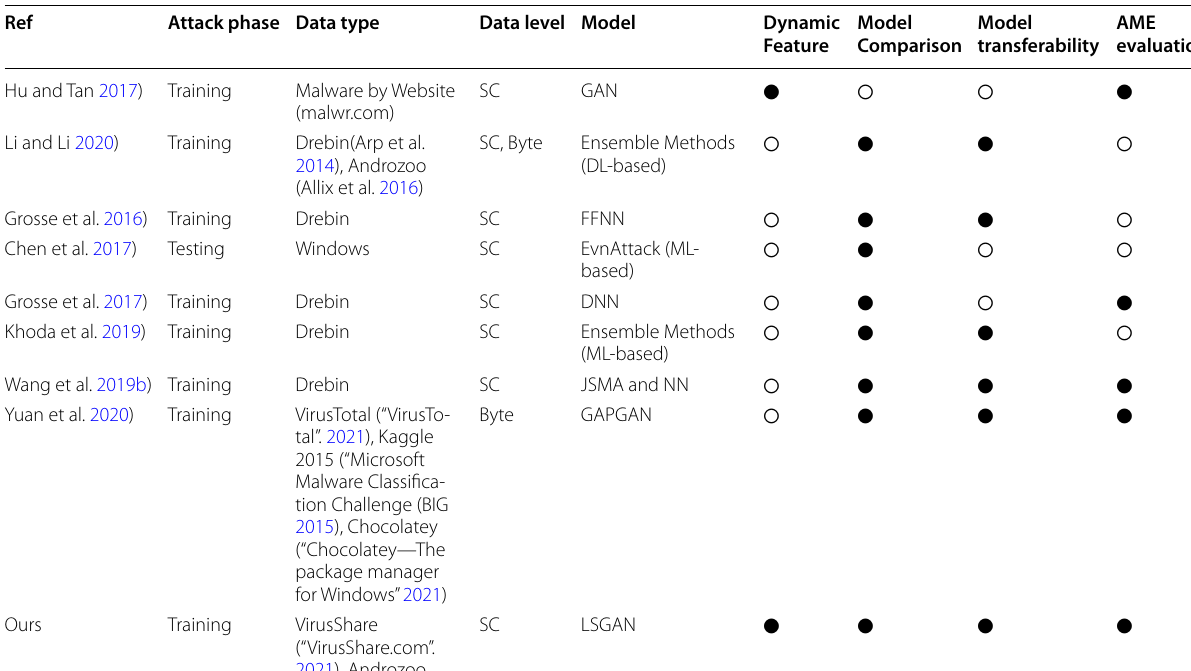
Table 1 Related work of evasion attacks in malware detection